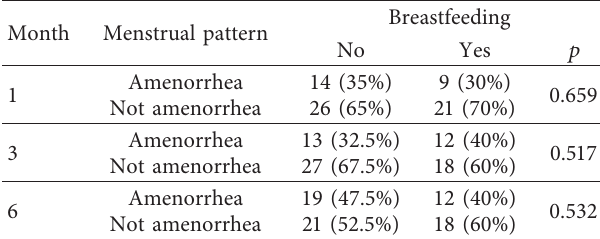
Table 8: The relationship between breastfeeding and amenorrhea in one-rod users.